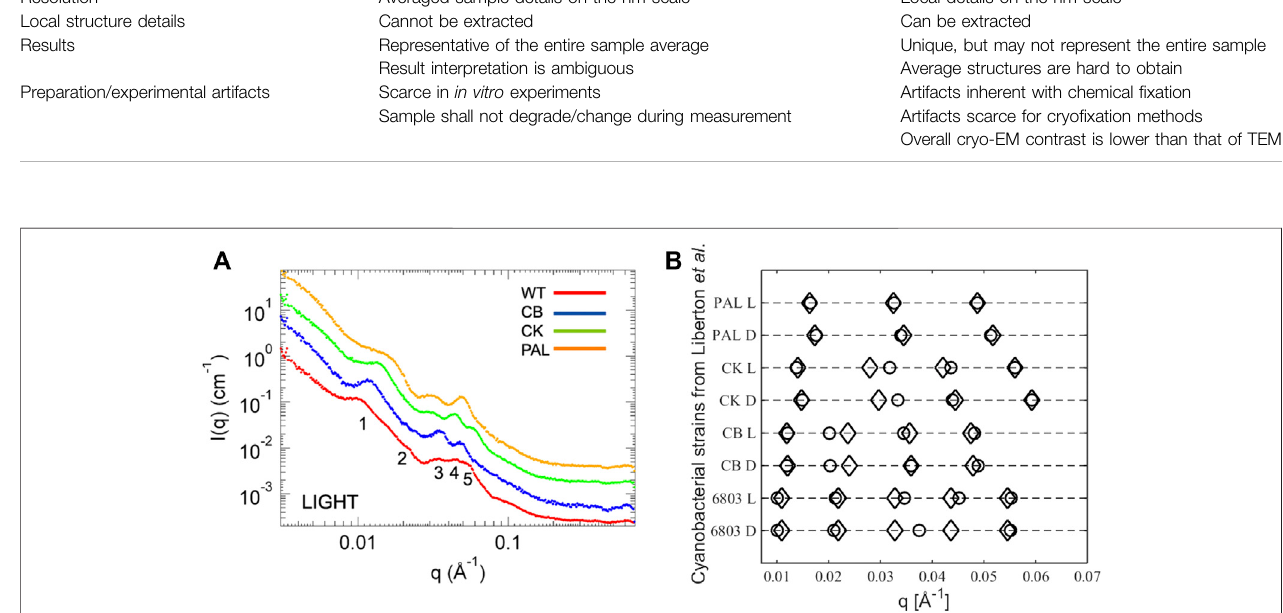
FIGURE 5 | (A) X-ray scattering curves of cyanobacterial systems: Synechocystis sp. PCC 6803 (WT), CB, CK, PAL mutants. (B) Plot of the peak positions from Liberton et al., 2013b. Circles are data values as reported and diamonds are the q values calculated using the Bragg equation ( Eq. 2 ) with the lowest q value asthe fi rst- order